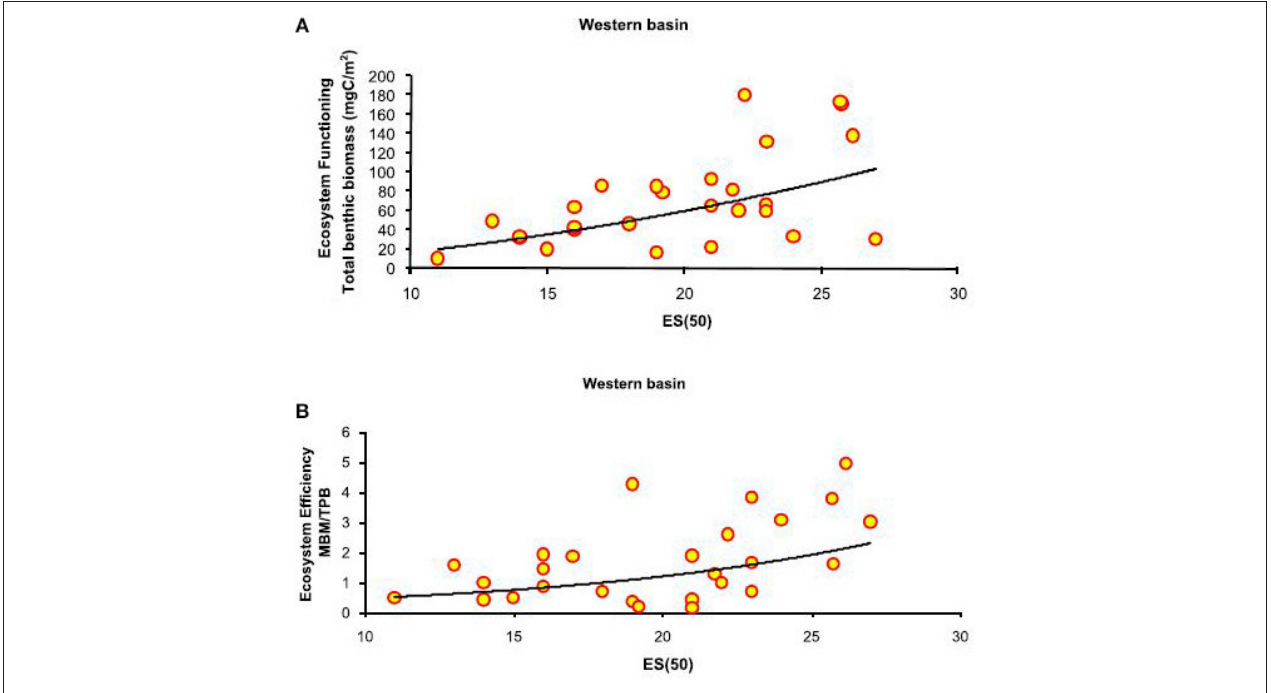
FIGURE 3 | Basin-scale relationships between macrofauna biodiversity and ecosystem functioning and efficiency. (A) Relationship between expected species richness (ES (50) ) and ecosystem functioning, expressed as total benthic biomass (mgC/m 2 ). The equation of the fitting line is y = x ∧ 1.43 ( N = 27; R 2 = 0.32; P < 0.01). (B) Relationship between expected species richness (ES (50) ) and ecosystem efficiency, expressed as macrobenthic biomass to prokaryotic biomass (MBM: TPB). The equation of the fitting line is y = e ∧ ( − 1.90 + 0.12x) ( N = 27; R 2 = 0.33; p <